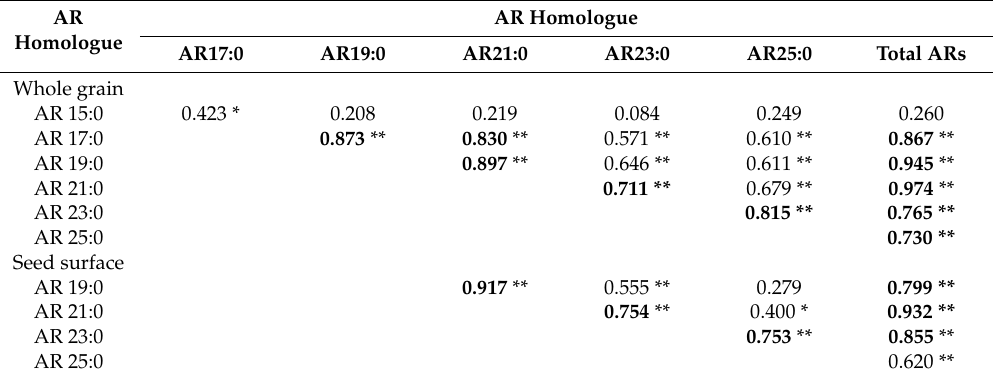
Table 2. Correlation coefficients between AR homologues content in whole grains and seed surfaces.